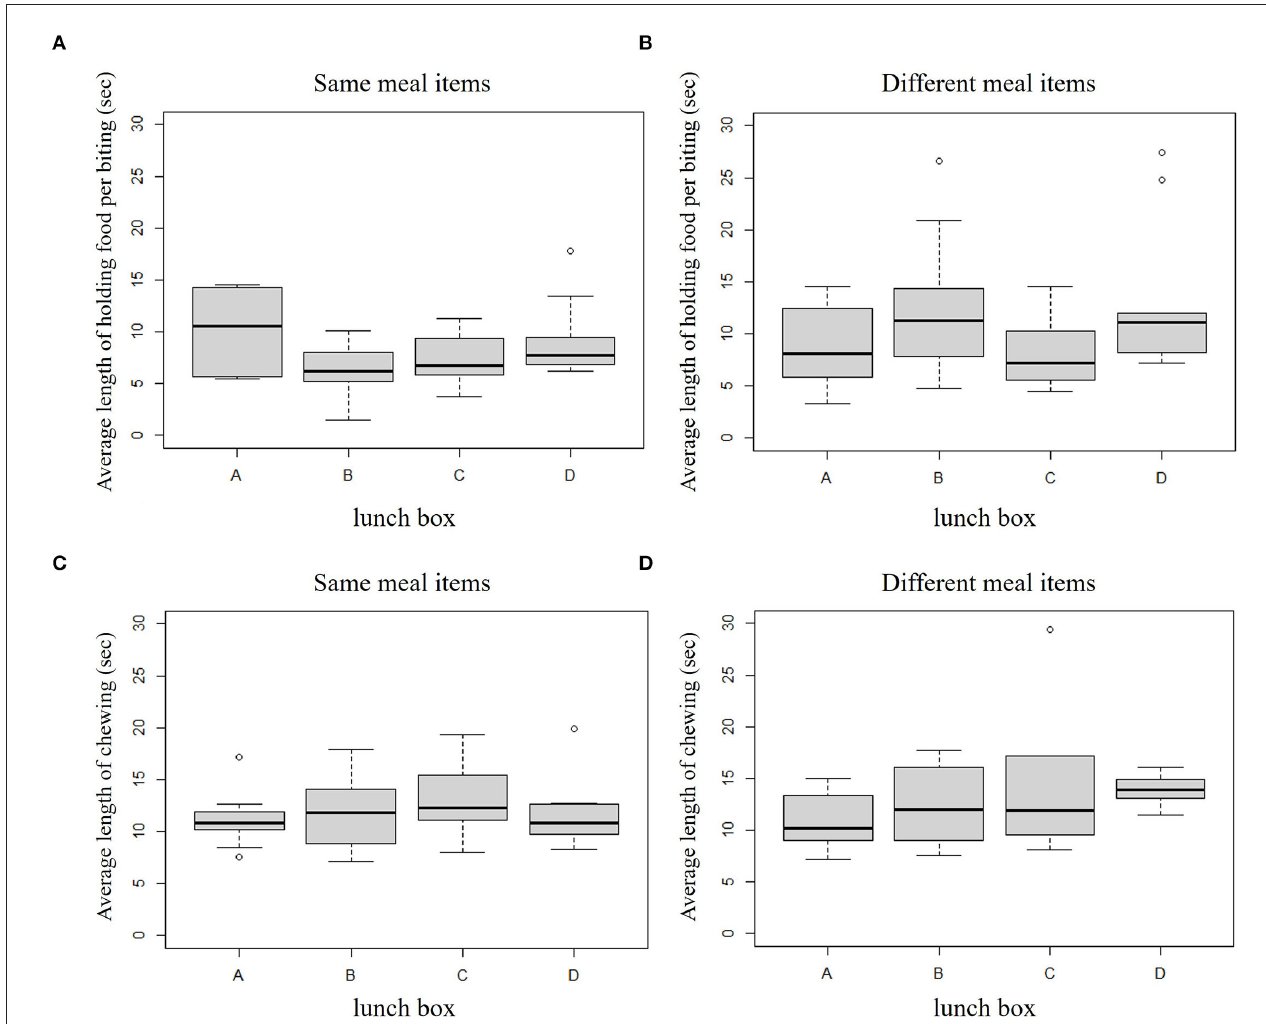
FIGURE 7 | Average lengths of holding food per bite in (A) the “same meal items” condition and (B) the “different meal items” condition using four lunch box sets. Average lengths of chewing in (C) the “same meal items” condition and (D) the “different meal items” condition using four lunch box sets.